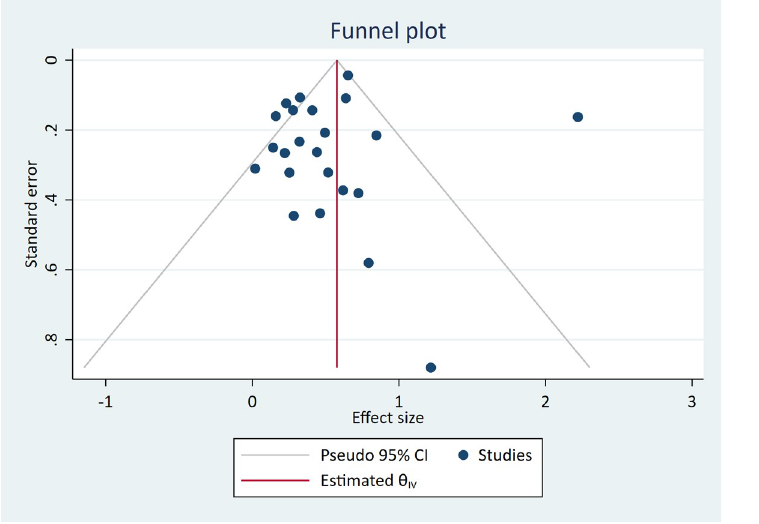
Fig 6. Funnel plot for complex working memory meta-analyses.